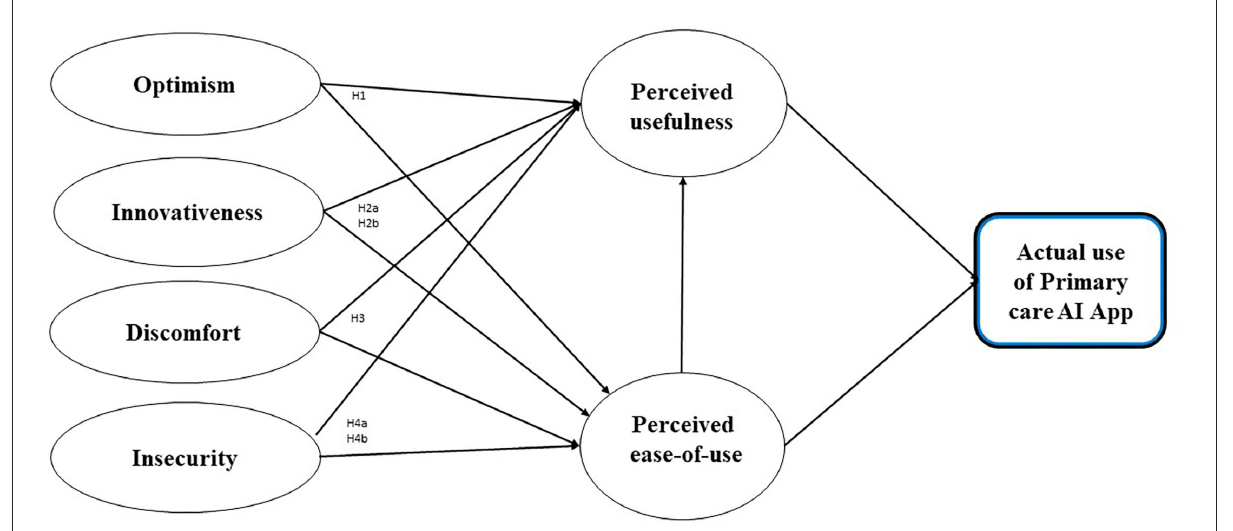
FIGURE1 The integrated model (TRAM) with hypothesized relations among study